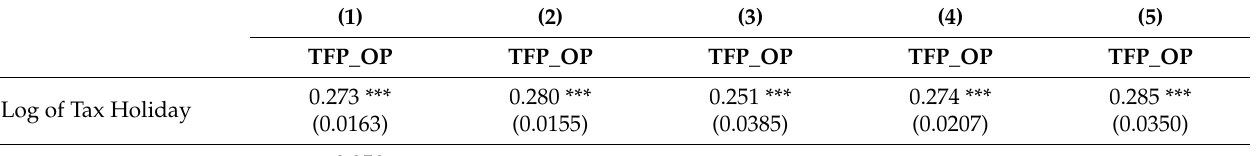
Robust standard errors in parentheses, clustered at the firm level. All regressions include firm fixed effects and